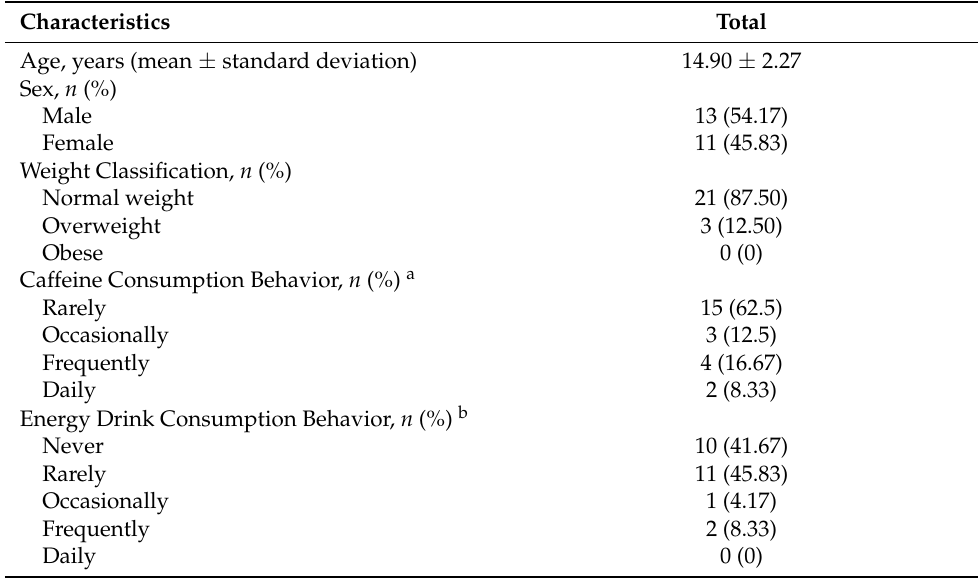
Table 1. Study Participants’ Characteristics ( n = 24).